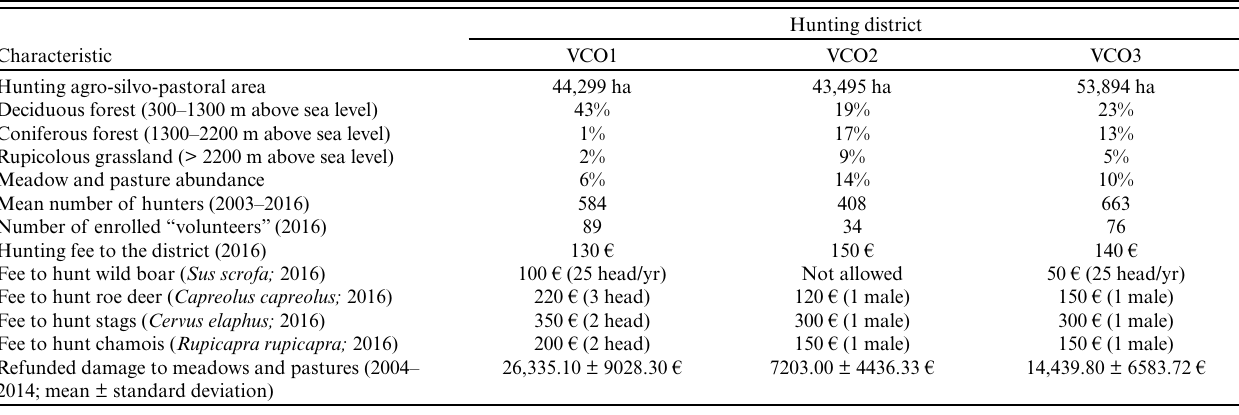
Table 1. Verbano-Cusio-Ossola (VCO) province hunting district characteristics, including habitat, numbers of hunters and volunteers, hunting fees, and cost of damages to meadows and pastures caused by wild boar.